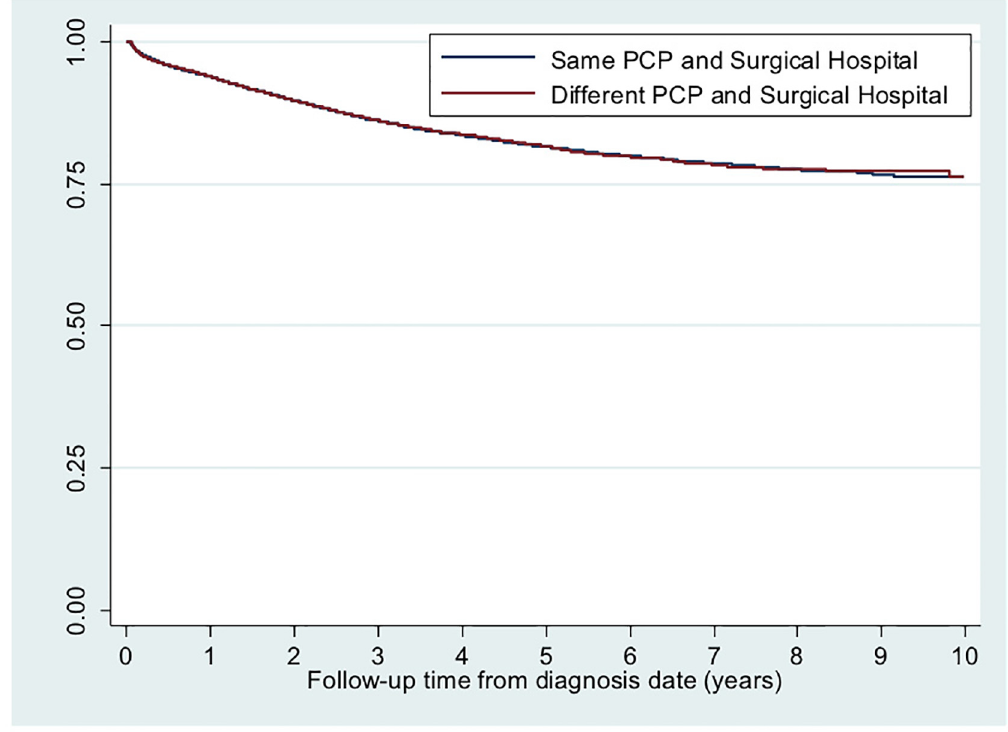
Fig 3. Kaplan Meier survival curve for colon cancer specific mortality by same versus different hospital primary and surgical care delivery. Average follow-up time: 3.7 years. Total follow-up time: 86,567 years. Log rank survival function: chi square = 0.10, p = 0.75. Test of non-zero slope: p = 0.21.